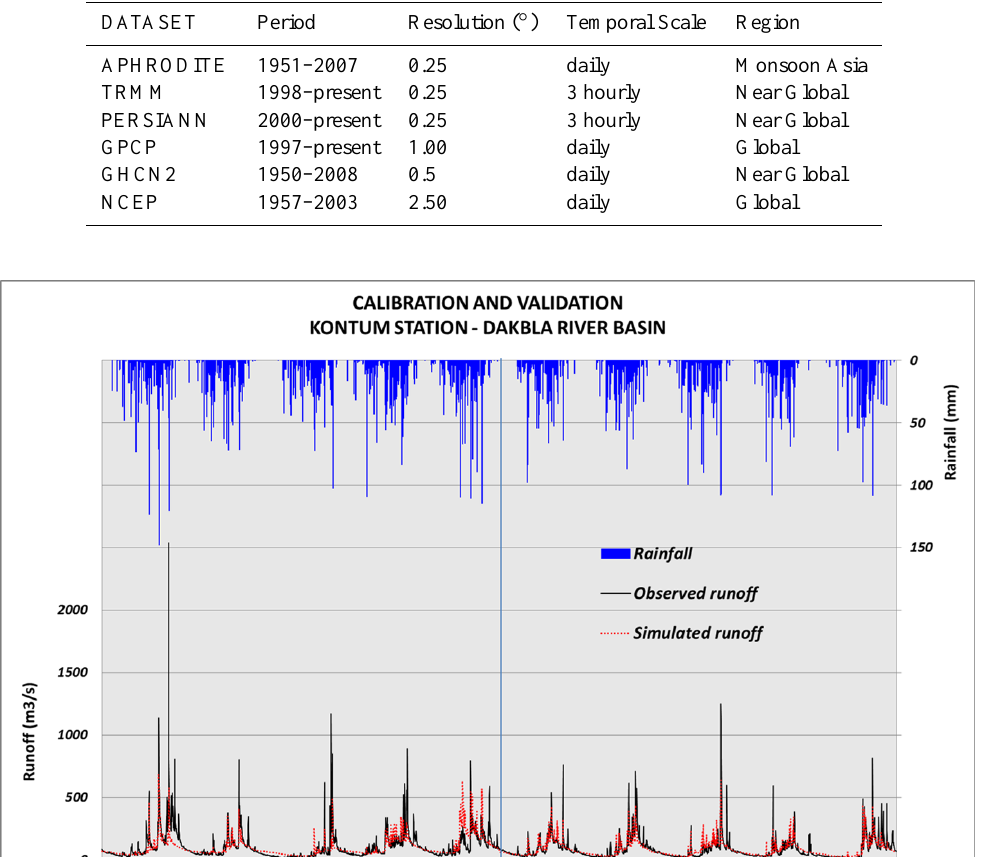
Table 1. Gridded observations and Reanalysis datasets used in the study.